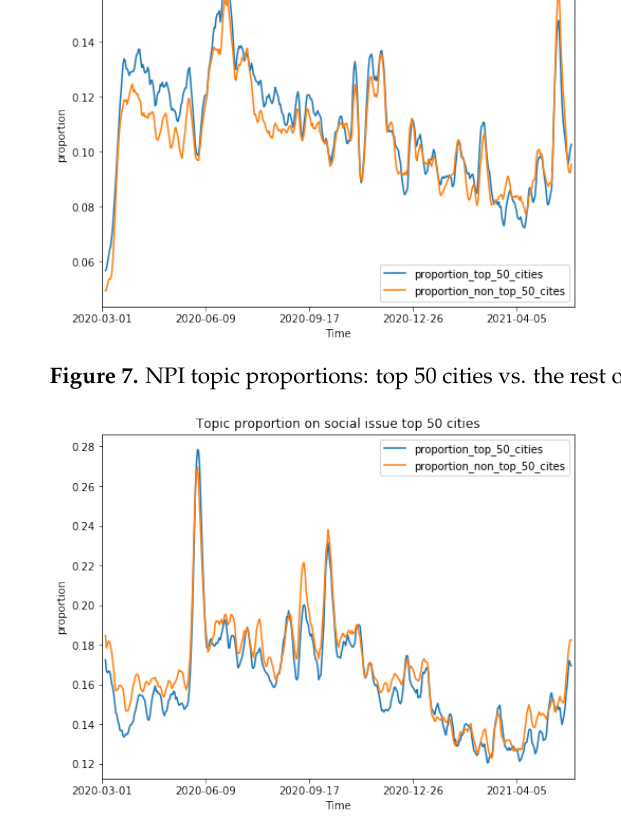
Figure 8. Social issue topic proportions: top 50 cities vs. the rest of the